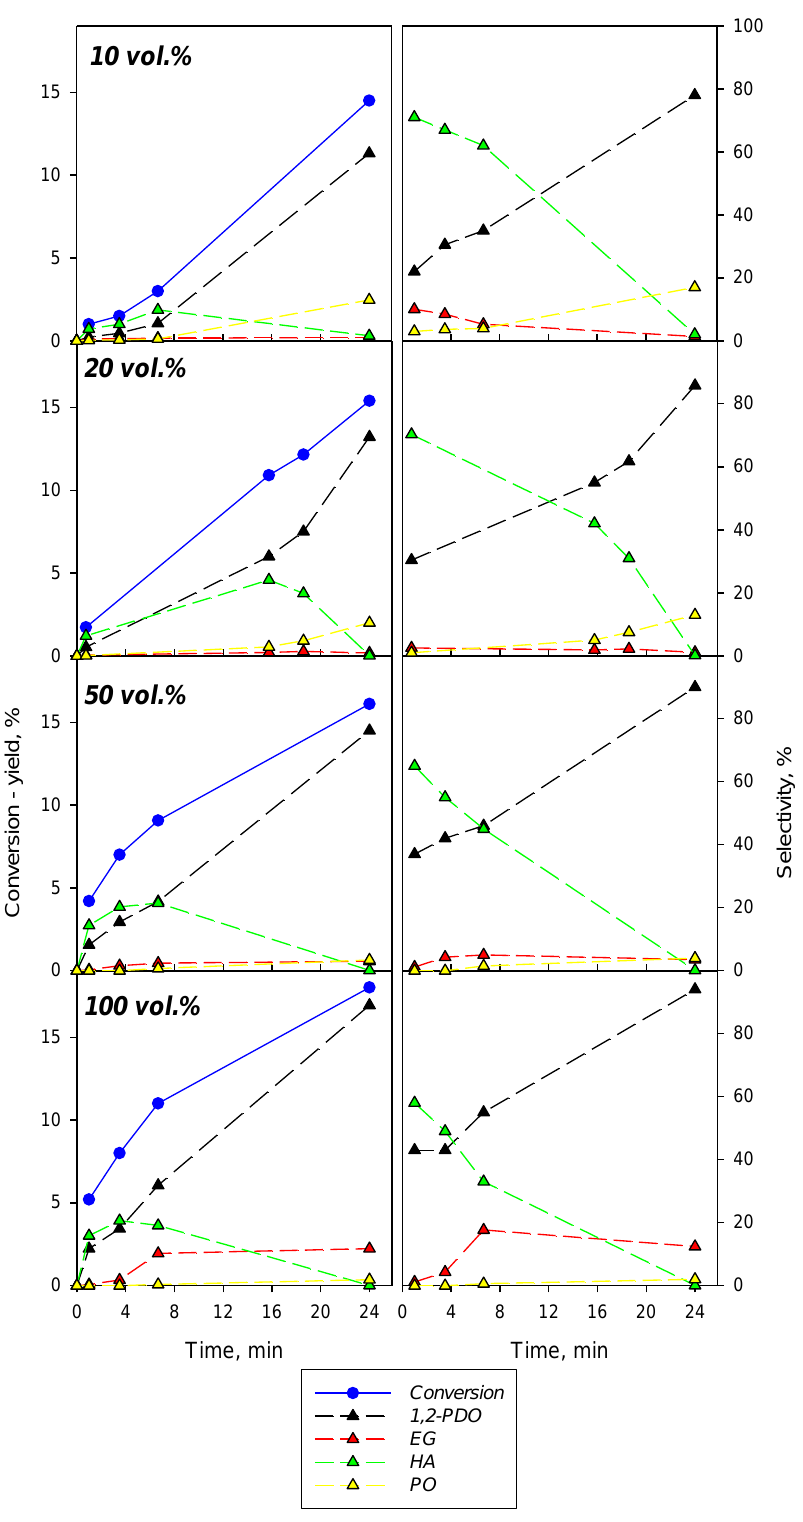
Figure 9. Cu(M)-Zr(C) glycerol conversion, yields, and selectivities to products as a function of the reaction time at different H 2 partial pressures. Initial P = 20 bar(g); T = 240 °C; rotation speed = 500 rpm (PDO = 1,2 propanediol, EG= ethylene glycol, HA = hydroxyacetone, PO = 1-propanol).